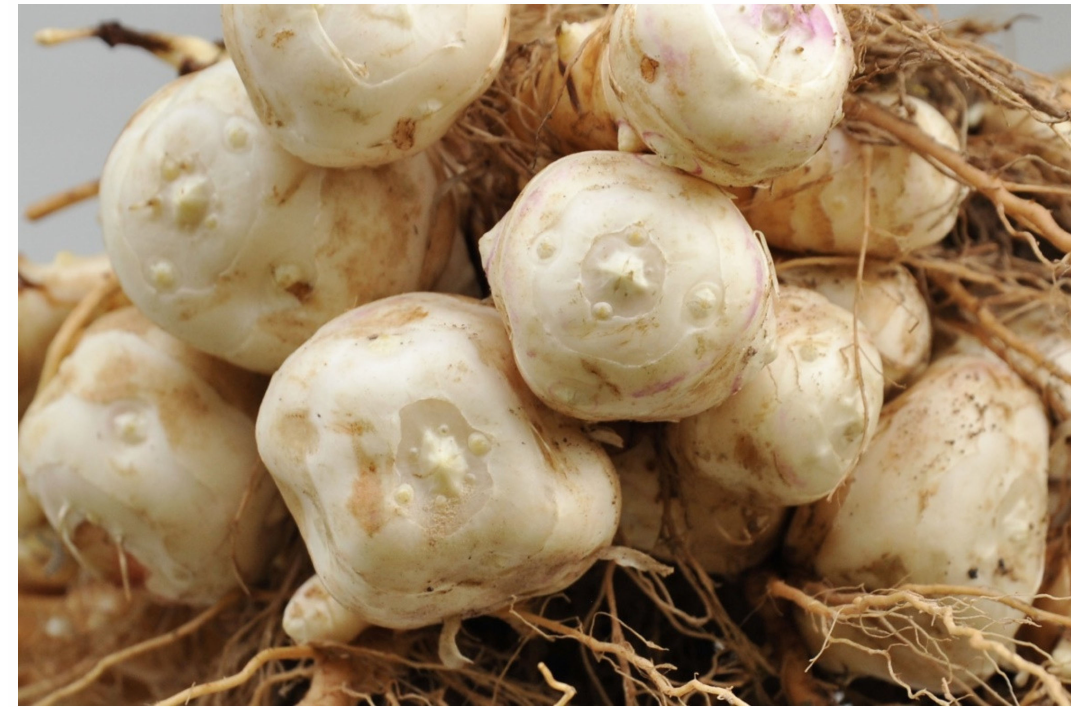
Figure 1. Tubers, stolons, roots, and rhizomes of the ‘Albik’ cultivar ( H. tuberosus L.). Source: own photo.